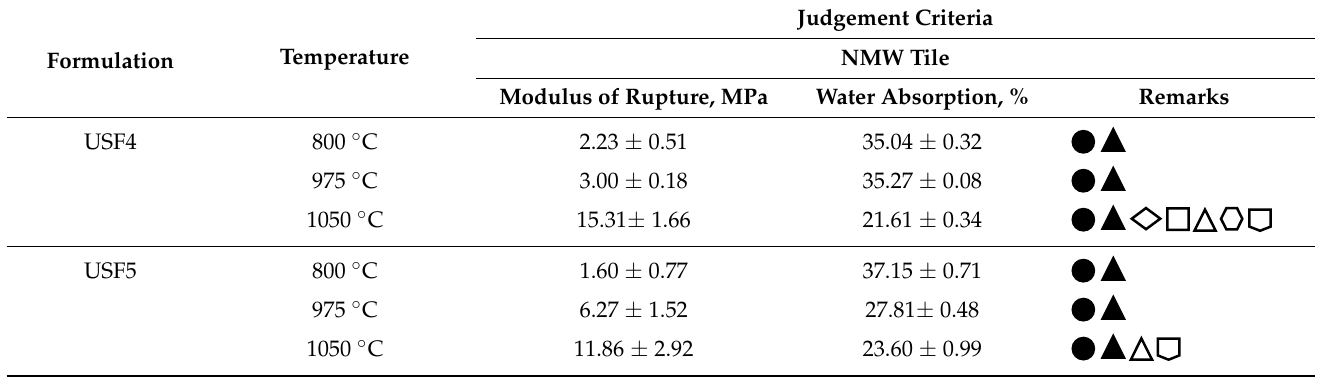
Table 5. Quality compliance summary .